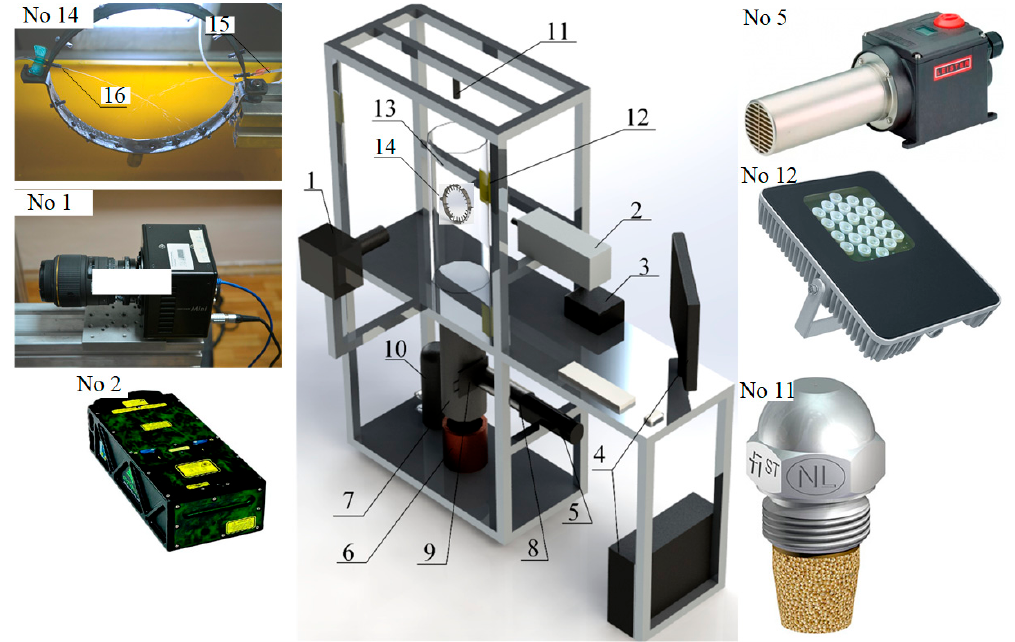
Figure 1. Scheme of experimental setup: 1—high-speed video camera (depending on the objectives,